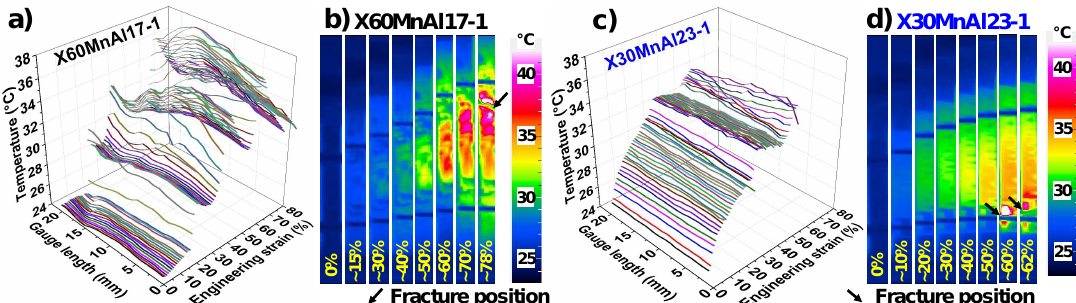
Figure 8. Temperature increase due to adiabatic heating in the macroscopic tensile tests carried out in conjunction with infrared thermography camera and video extensometer: ( a , c ) Rise in surface temperature during deformation, ( b , d ) Distribution of local temperature at different elongations and at